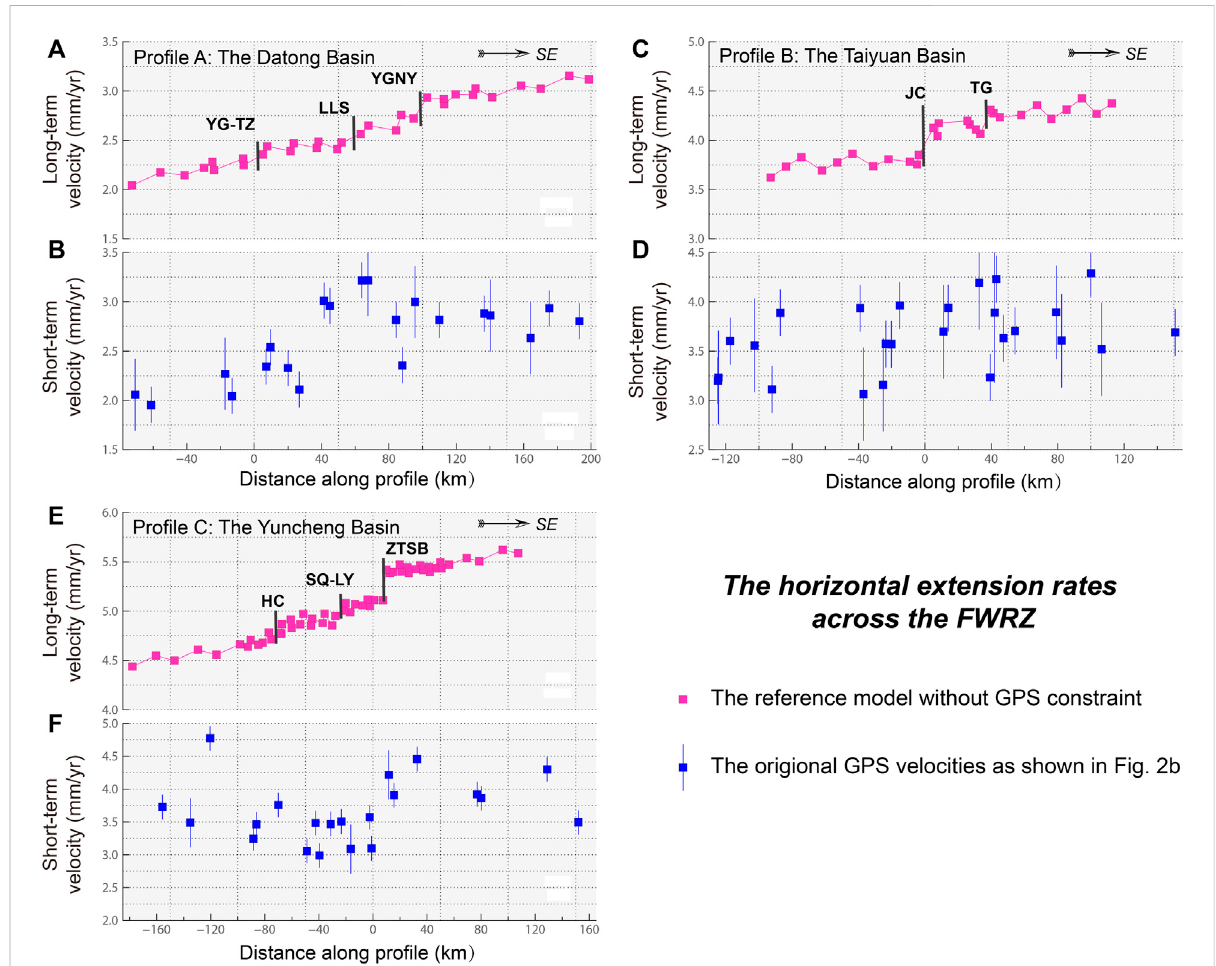
FIGURE 10 The long-term horizontal velocity pro fi les (pink square dots, see Figure 7 for the pro fi le location) from our reference model and GPS (short- term) velocity pro fi les (blue square dots, see Figure 2B for the pro fi le location) perpendicular to the striking direction of primary active faults. (A, B) : the long-term and short-term velocity pro fi le of the Datong Basin; (C, D) : the long-term and short-term velocity pro fi le of the Taiyuan Basin; (E, F) : the long-term and short-term velocity pro fi le of the Yuncheng Basin; Abbreviations of faults are given in Figure